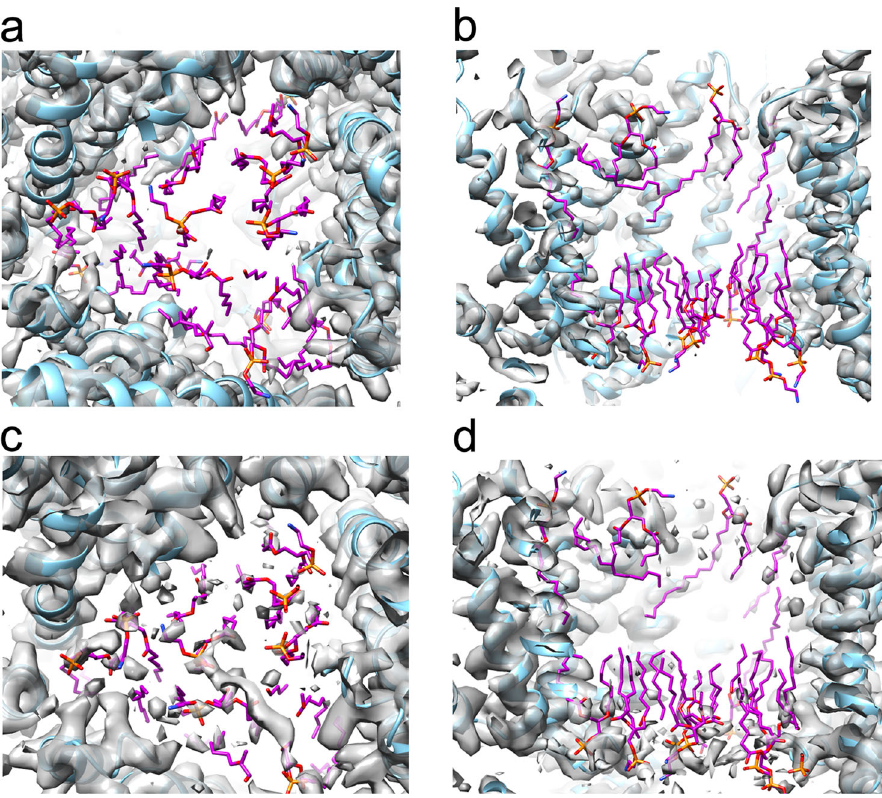
Fig. 4 Analysis of the lipid-binding site in AcrB. Density map of C 8 -C 0 -50-puri fi ed AcrB seen around the transmembrane region from the side and base. The lipids from AcrB solved by cryoEM in SMA are superimposed and shown in purple, red and orange for carbon, oxygen and phosphate, respectively. The density contour level in ( a ) and ( b ) is comparable to that of Fig. 3c (0.025), a lower threshold of density (0.016) is shown in ( c ) and ( d ) with increased noise. At both contour levels, no density is present that could be assigned to the bound